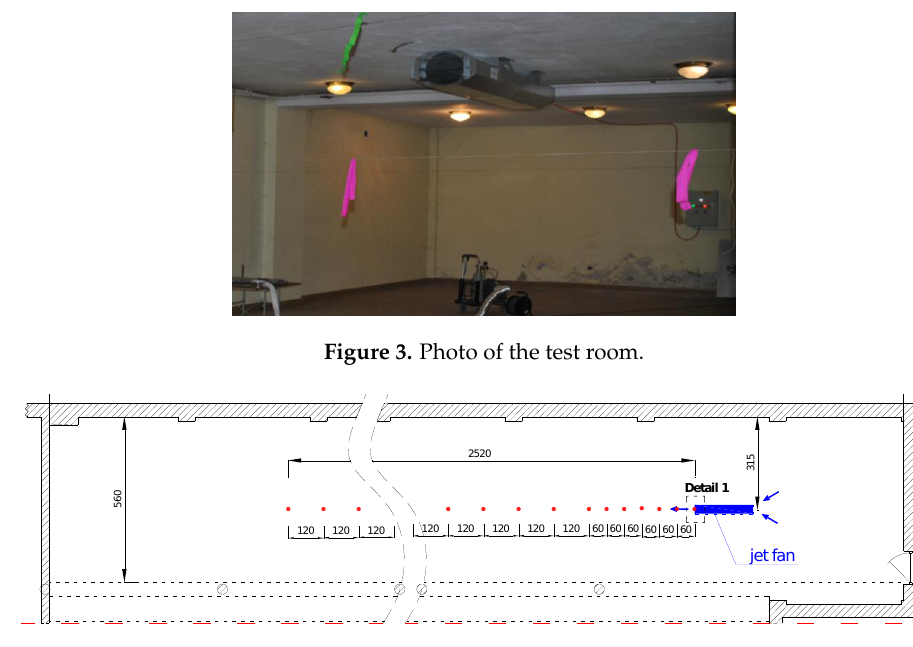
Figure 4. Test room scheme with measuring points presentation.